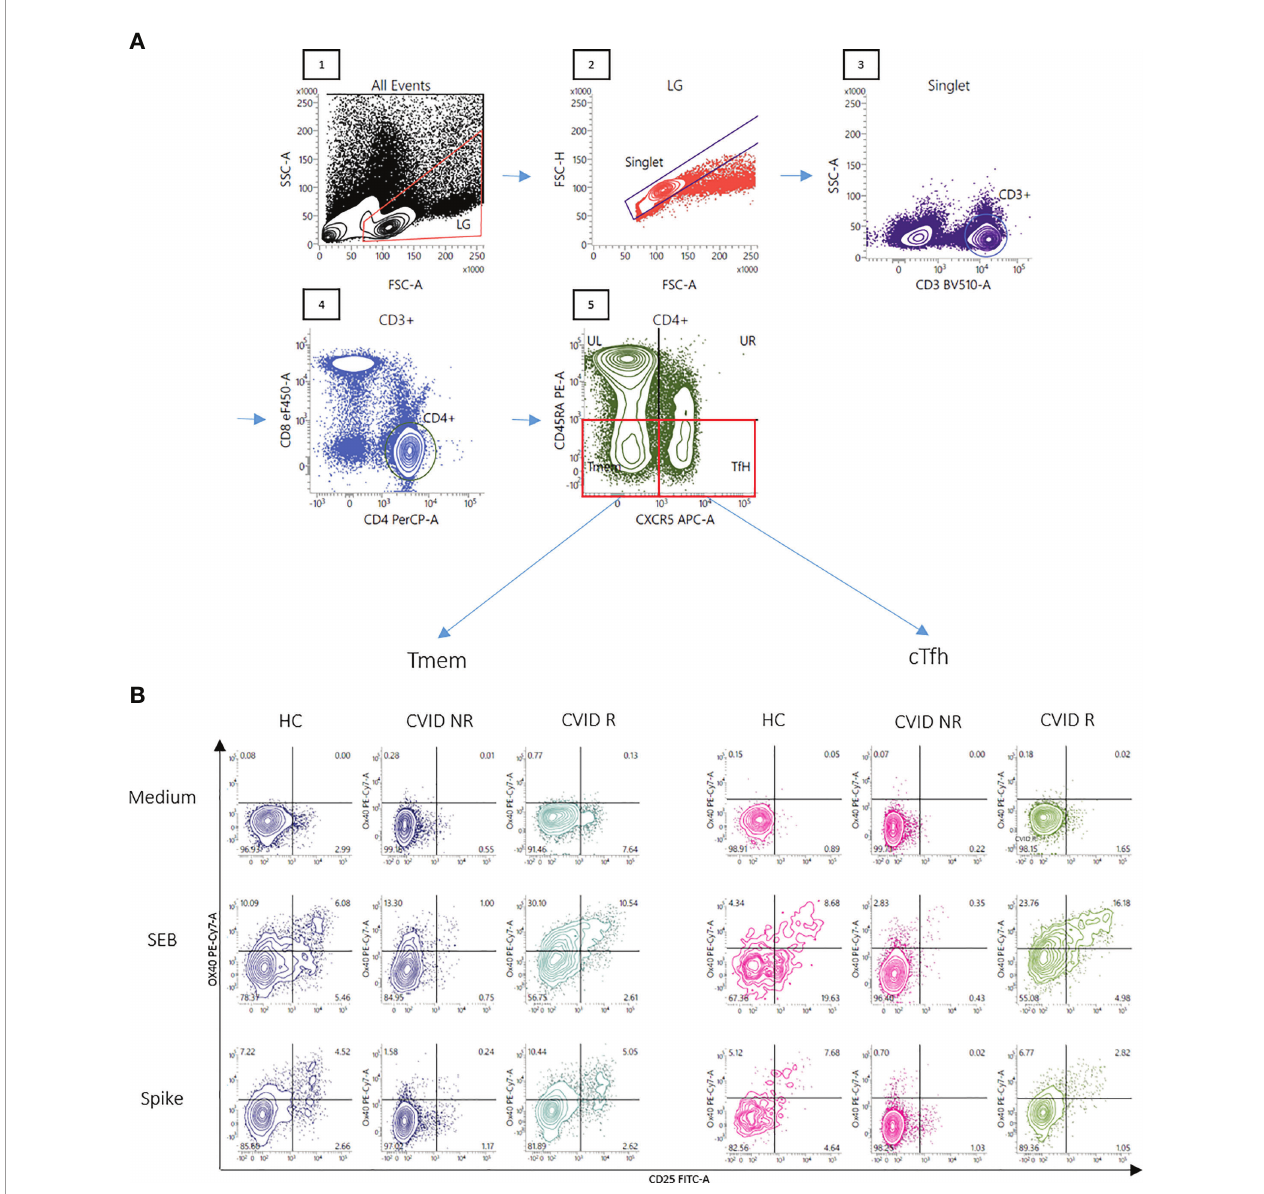
FIGURE 1 | Gating strategy and representative FACS plots of CD4 + T memory cells responsive to SARS-CoV-2 spike peptides. Panel (A) A lymphocyte gate was applied to a forward - sideward scatter plot of all events (1), followed by doublet exclusion using forward scatter area vs height for cells within the lymphocyte gate (LG) (2). CD3 + cells were then selected out of singlets (3) and CD3 + T-cells were examined for CD4 staining (4). Finally CD3 + CD4 + CD45RA - T-memory cells were divided into CXCR5 - (Tmem) and CXCR5 + (cTfh) cells (5). OX40(CD134) + CD25 + cells were fi nally de fi ned as activated T-cells. Panel (B) Activation of Tmem and cTfh cells after stimulation of the cells with SEB or overlapping peptides of SARS-CoV-2 spike protein is shown in a representative healthy control (HC), a CVID patient IgG-responsive to BNT162b2 vaccination (CVID R, SARS-CoV-2 IgG antibody level following the second vaccination more than 33 RE/ml) and a CVID patient IgG- non-responsive following mRNA vaccination (CVID NR, SARS-CoV-2 IgG below 33 RE/ml following the second vaccination). Unstimulated control cells were incubated in medium alone (Medium). The percentages of OX40(CD134) + and CD25 + double-positive activated CD4 T cell subsets are shown in the upper right panel of the respective FACS